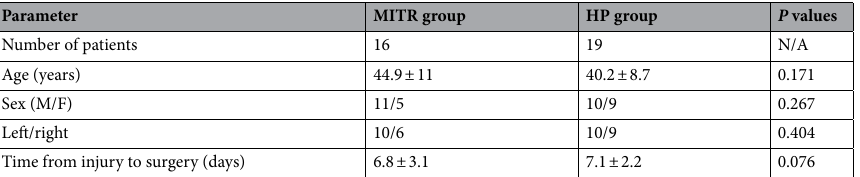
Table 1. Patient demographic characteristics (mean ± SD). M male, F female, MITR minimally invasive coracoclavicular fixation with a single TightRope, HP , hook plate.